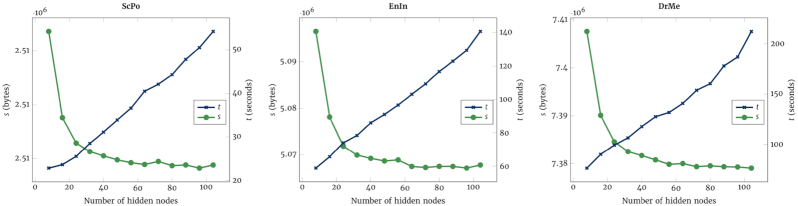
Number of bytes (s) and time (t) according to the number of hidden nodes for the reference-free compression of ScPo, EnIn, and DrMe sequence genomes.